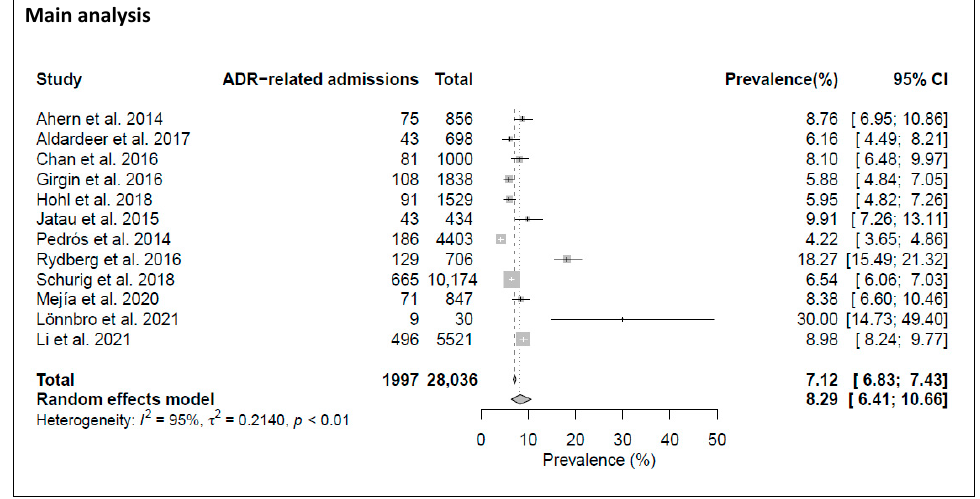
Figure 2. Main analysis. Forest plot of the pooled prevalence of ADR-related admissions to EDs or inpatient wards